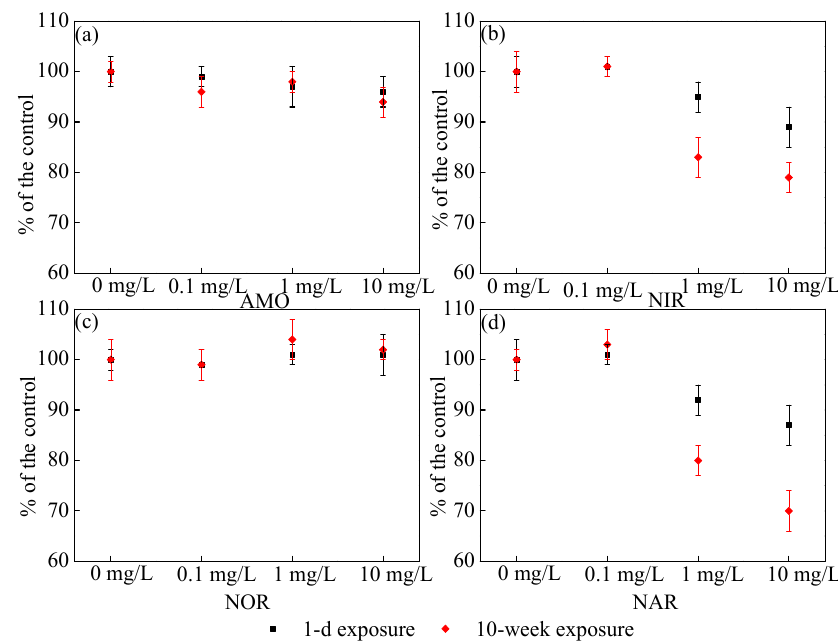
Figure 4. Relative activities of AMO ( a ), NIR ( b ), NOR ( c ), and NAR ( d ) in active sludge during one cycle after 1 day ( ■ ) and 10 weeks ( ◆ ) of exposure. Error bars represent standard deviations of triplicate measurement.